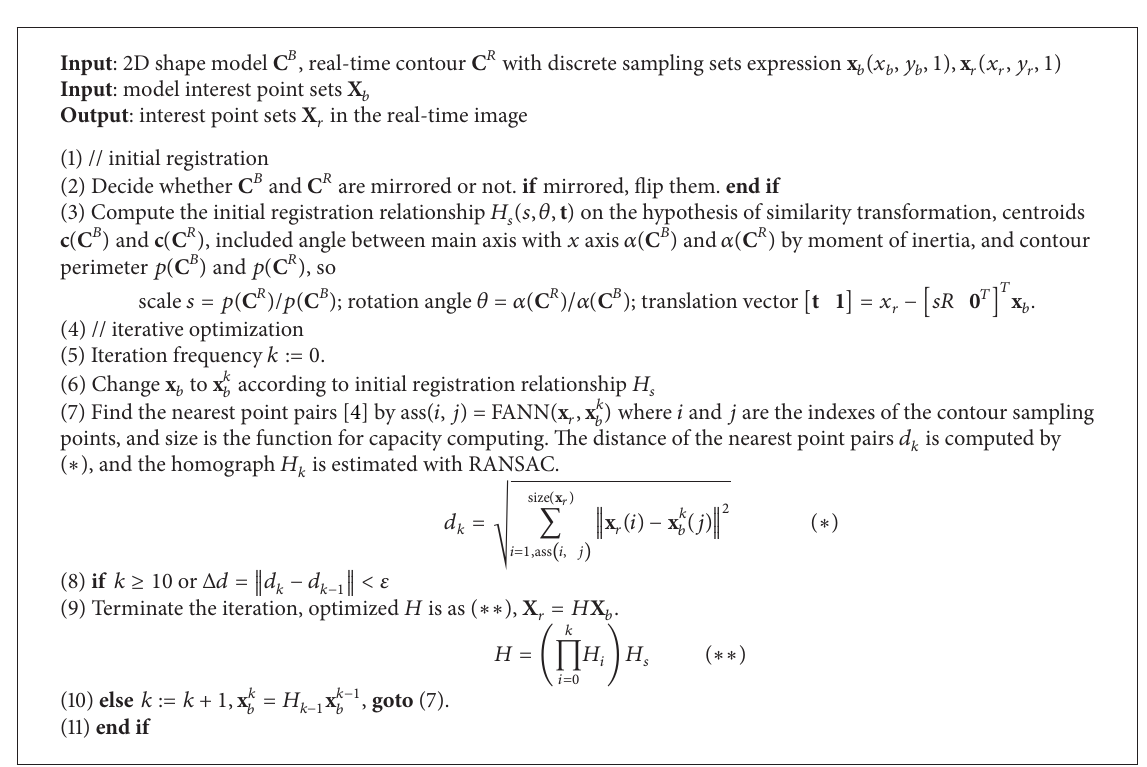
Algorithm 1: Multiple interest points location based on 2D contour model.